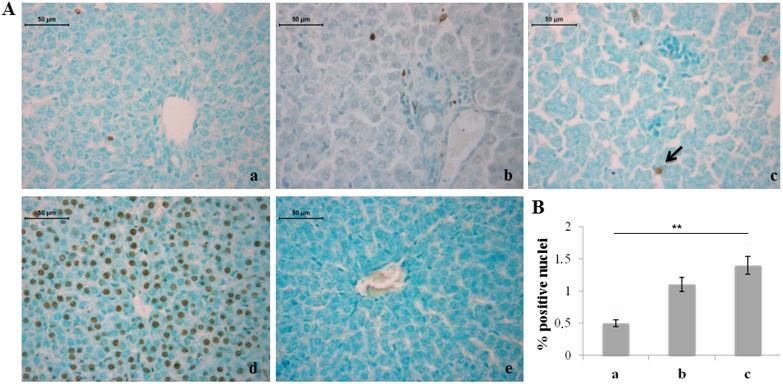
Severe hyperoxia increases hepatocyte apoptosis.A) TUNEL detection of apoptotic nuclei (arrow) in neonatal rat livers exposed to moderate and severe hyperoxia. a) ambient air; b) 60% hyperoxia; c) 95% hyperoxia; d) positive control; e) negative control. Scale bar: 50 µm, magnification 40x. B) Graphic representation of the percentage of TUNEL positive nuclei (±SD) determined by direct visual counting of ten fields for each of three slides per sample. ** = p<0.01.